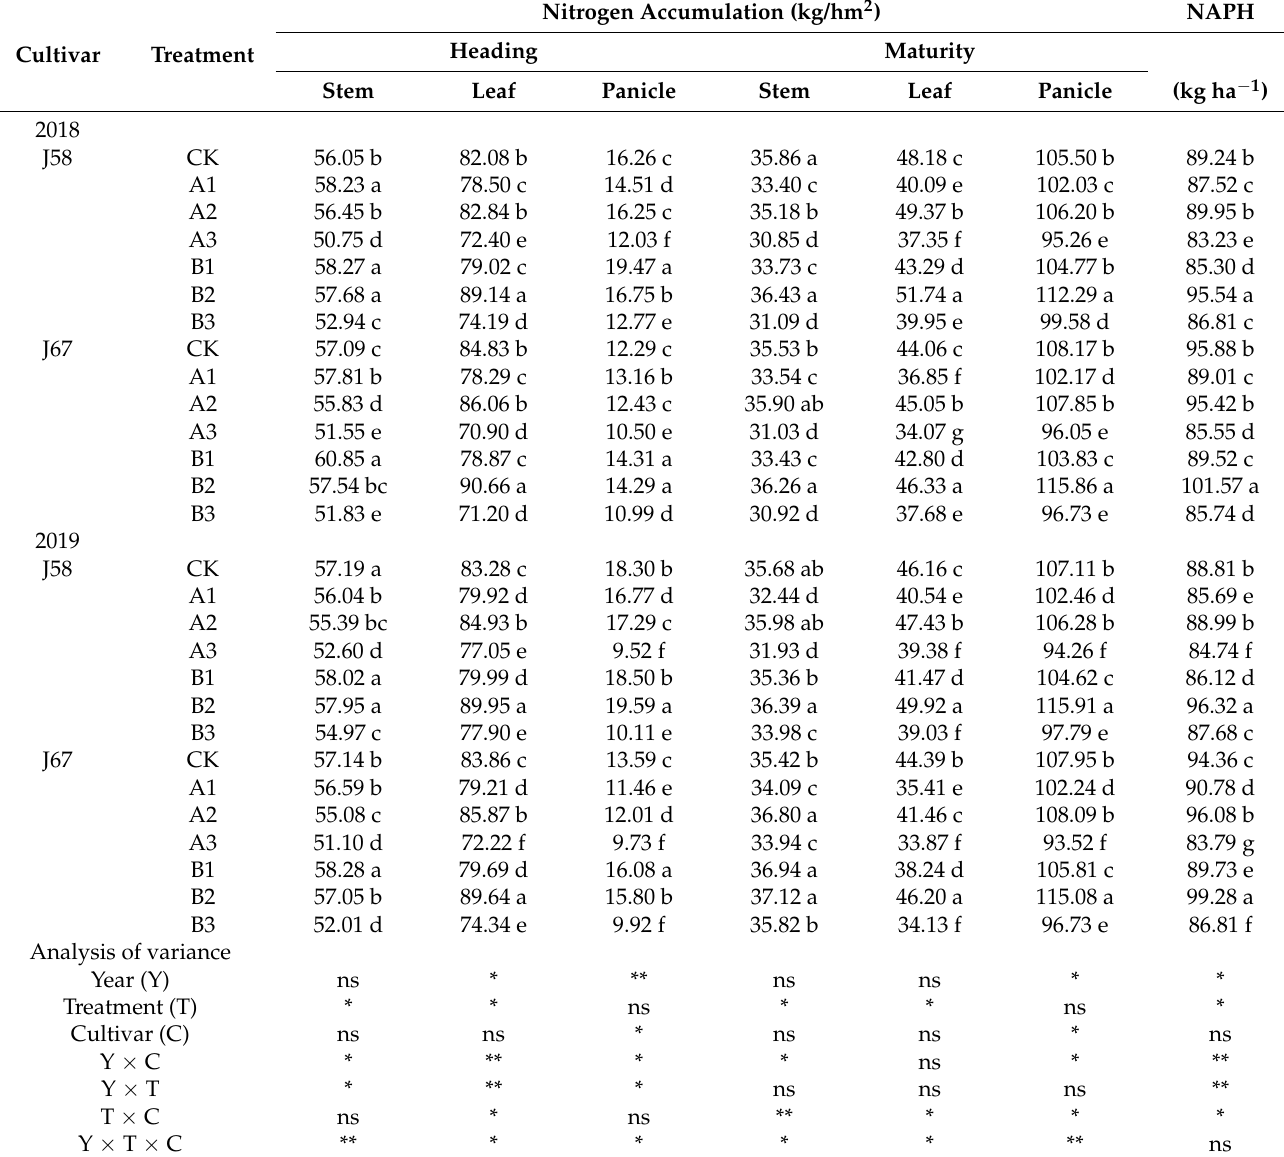
Table 7. Differences in N accumulation in each rice organ at the heading and maturity stages 2